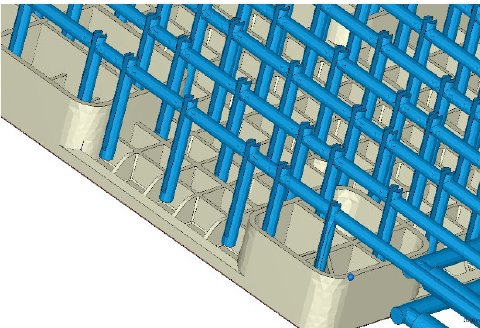
Figure 2. An injection-compression-molded HDPE half-pallet: ( a ) isometric view of the filling gate and the top side of a half-pallet (1320 mm × 1100 mm × 75 mm); ( b ) isometric view of stiffened ribs on the bottom side of a half-pallet; ( c ) dimensions of a welded whole HDPE pallet (1320 mm × 1100 mm × 140 mm); ( d ) isometric view of the baffle cooling flow system on the top side of a half-pallet; ( e ) isometric view of the baffle cooling flow system on the bottom side of a half-pallet; ( f ) detailed view of the baffle cooling flow system.